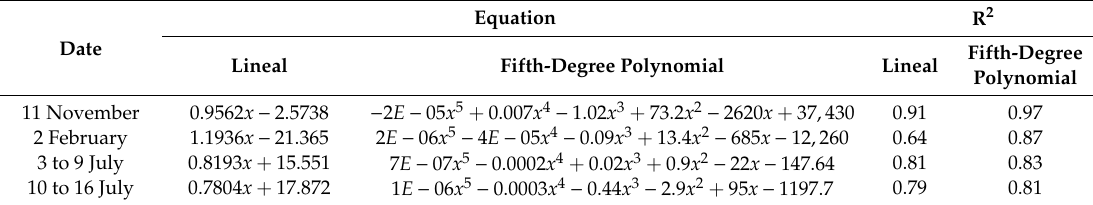
Table 3. The R 2 values calculated using linear regression and a fifth-degree